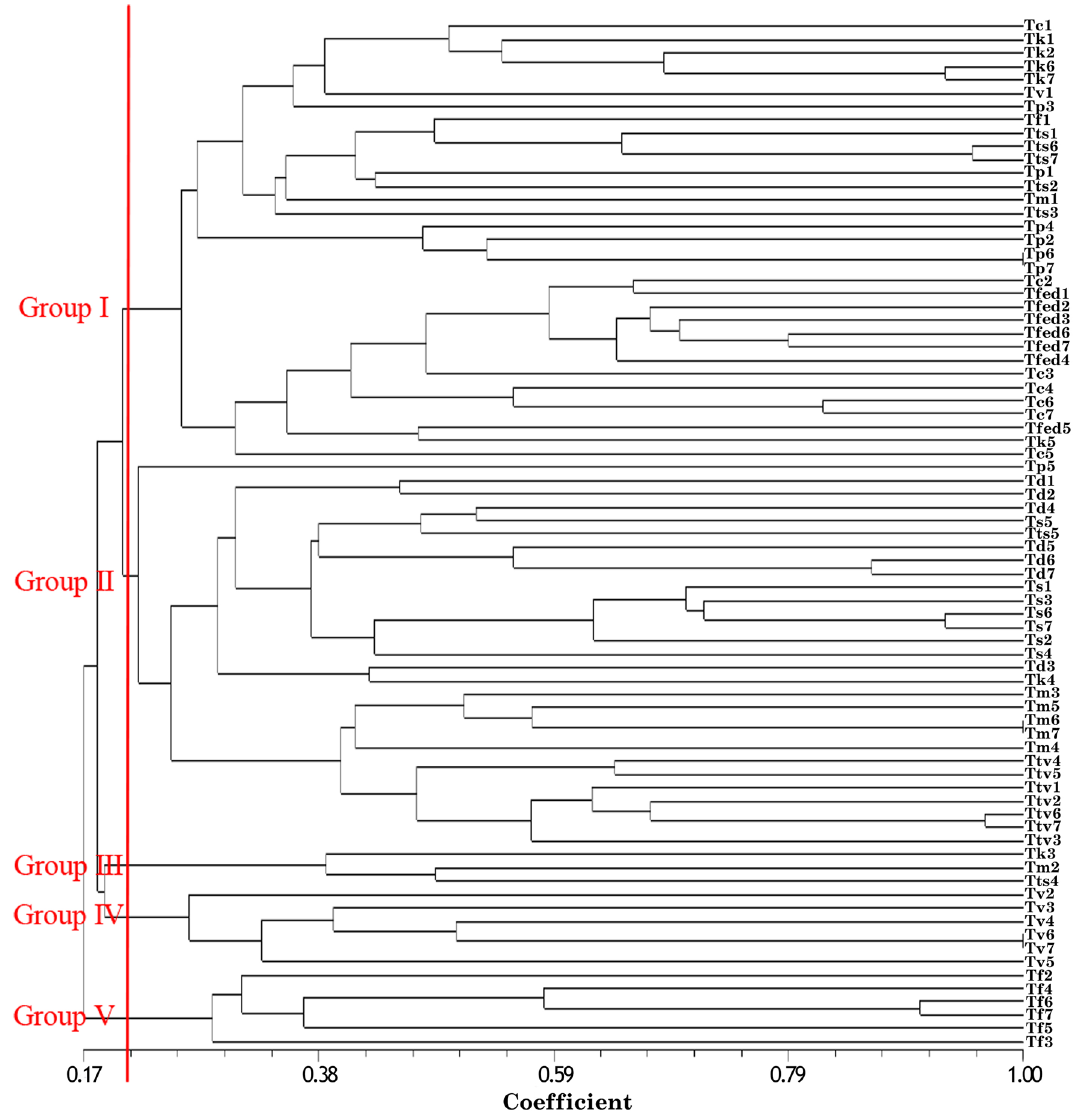
Figure 4. Dendrogram of 77 studied Thymus genotypes based on SRAP markers according to the Unweighted Pair Group Mean Algorithm (UPGMA) with the Jaccard similarity